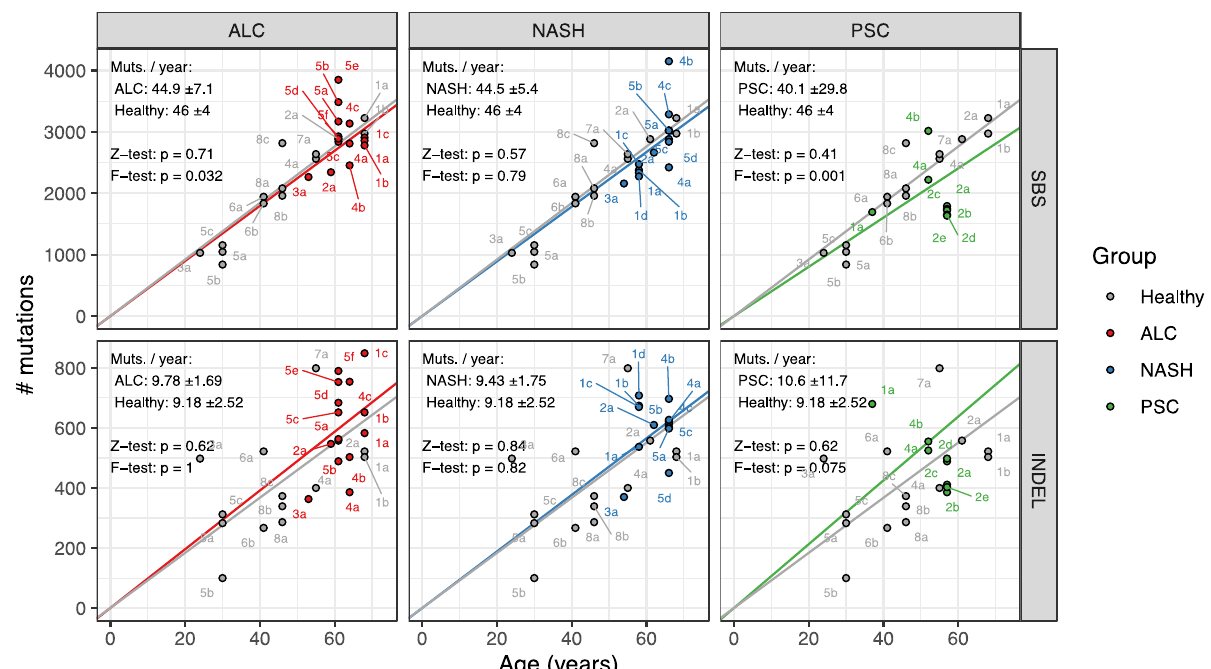
Fig. 2 Accumulation of somatic single base substitutions (SBS) and small insertions/deletions (indel) in organoids derived from biopsies of healthy livers compared to those from patients with diseased livers. ALC alcoholic cirrhosis, NASH non-alcoholic steatohepatitis, PSC primary sclerosing cholangitis. Each point is labelled by patient number and clone letter. Two-sided Z -tests were performed to determine whether there was a signi fi cant difference between the linear mixed effects regressions (i.e., the rate of mutation accumulation) of the disease versus healthy ICOs. One-sided F -tests were performed to determine whether there was a signi fi cant increase in variance in rate of mutation accumulation in disease samples versus healthy samples. ± values indicate the 95% con fi dence interval range of each regression and “ p ” indicates the p -values of the Z -tests and F